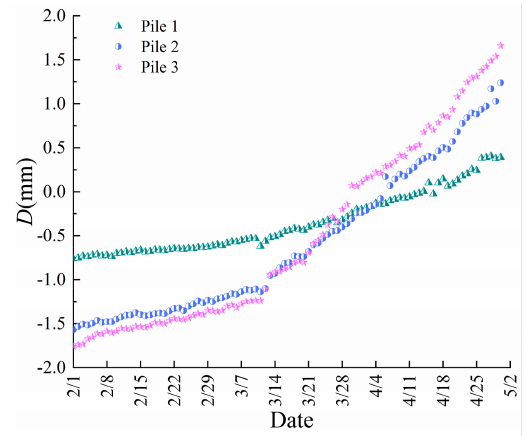
Figure 9. The horizontal displacement of the crown of the retaining piles.